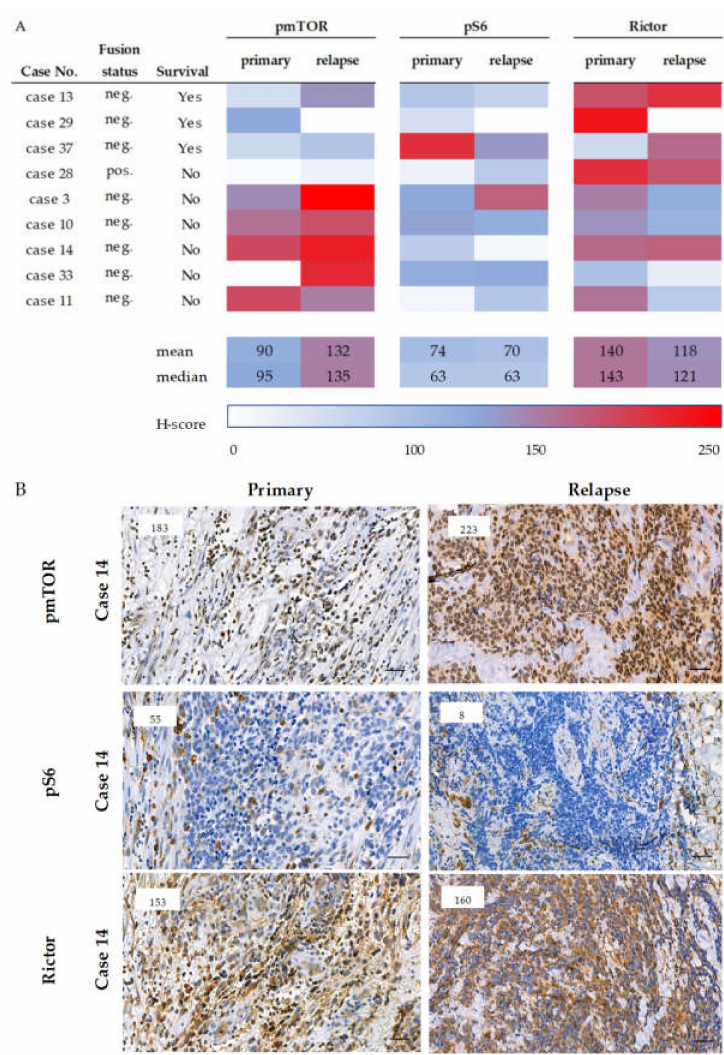
Figure 3. Expression of mTOR markers in primary and relapse paired samples. mTOR-related marker expressions of the paired (primary and recurrent) cases are presented (panel ( A )). The color scale represents the H-score in each case. Survival data and the fusion status are also given. Under the table ( A ), representative immunostainings of mTOR activity-related markers of primary and relapsed RMS cases are shown (panel ( B )). DAB (brown) and hematoxylin were used as chromogen and counterstaining, respectively. The numbers in the left upper corner of the pictures refer to the given H-scores. Pictures were taken with CaseViewer 2.3 software (3DHistech Ltd., Budapest, Hungary. The scale bars show 25 µ